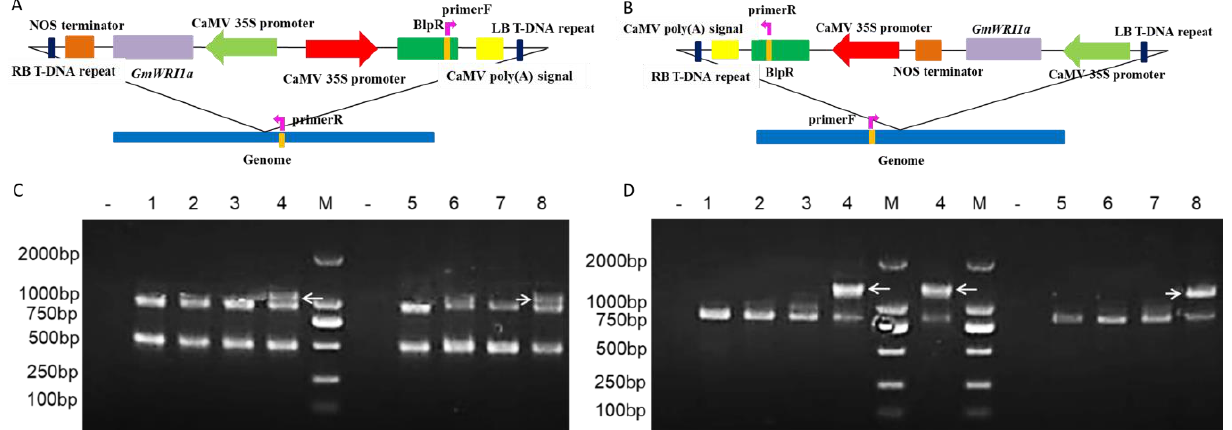
Figure 3. Integration sites of the T-DNA in 3-1 and 31-1 soybean. ( A ) Location of primers designed for event-specific PCR detection of 3-1. ( B ) Location of primers designed for event-specific PCR detection of 31-1. ( C ) Confirmation of the integration sites of the 3-1, predicted on the basis of DNA sequencing and data analysis results; Lane—is water (negative control); Lane M is 2000 bp molecular weight marker ladder; Lanes 1–4 are PCR amplification of bar and flanking region from the genomic DNA of T 3 generations 1-1, 31-1, 32-2, and 3-1 respectively; Lanes 5-8 are PCR amplification of bar and flanking region from the genomic DNA of T 4 generations 1-1, 31-1, 32-2, and 3-1, respectively. ( D ) Confirmation of the integration sites of 31-1, predicted on the basis of DNA sequencing and data analysis results; Lane—is water (negative control); Lane M is 2000 bp molecular weight marker ladder; Lanes 1–4 are PCR amplification of bar and flanking region from the genomic DNA of T 3 generations 1-1, 3-1, 32-2, and 31-1, respectively; Lanes 5–8 are PCR amplification of bar and flanking region from the genomic DNA of T 4 generations 1-1, 3-1, 32-2, and 31-1, respectively.